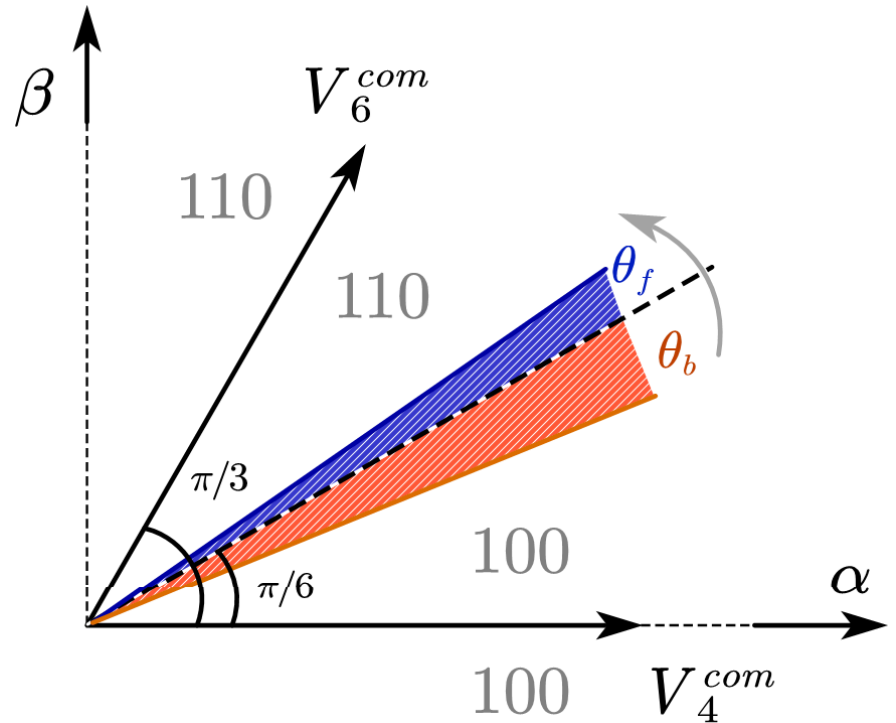
Figure 11. Forward and back lag angles for switching angle π